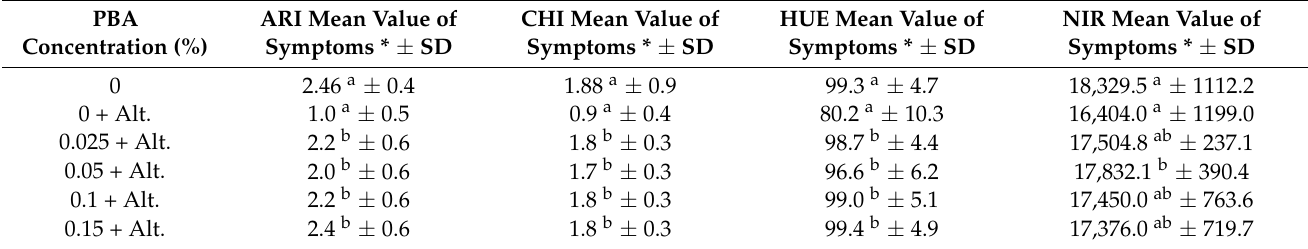
Table 8. Physiological parameters of tomato plants treated with PBA, 2 days later inoculated with Alternaria alternata and measured 15th day post ‐ inoculation.